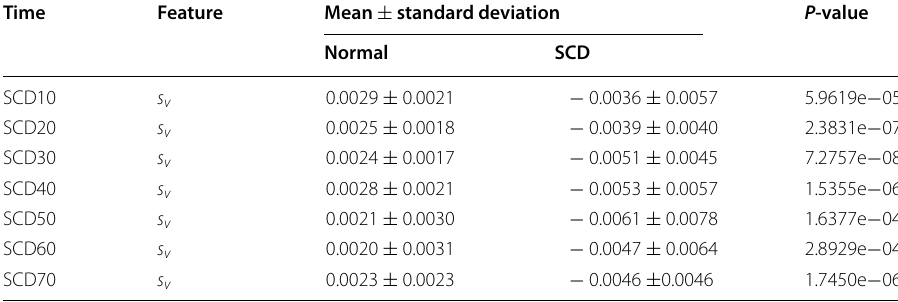
Table 2 Mean standard deviation of S v 70 min before SCD ±